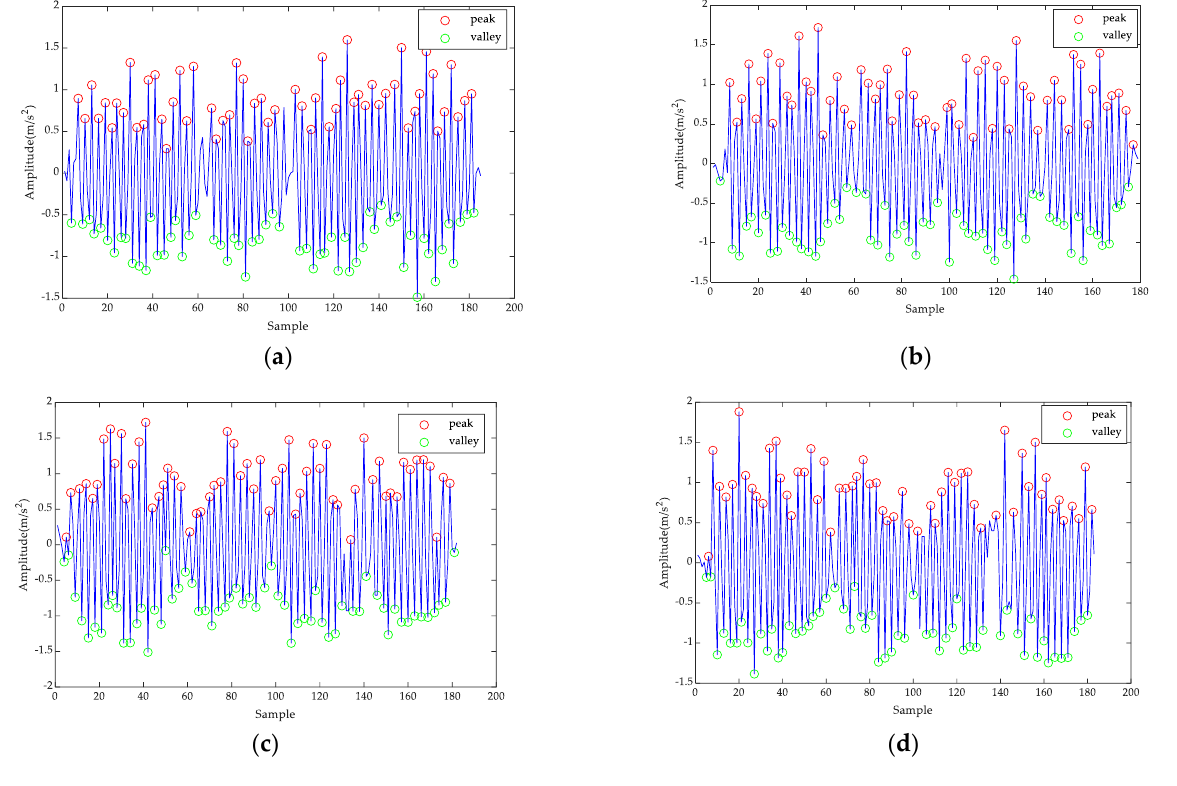
Figure 8. The peak and valley detection results with Honor60, VivoY85a, and two different height pedestrians in the second scene. ( a ) Volunteer #1 with a VivoY85a cell phone. ( b ) Volunteer #2 with a VivoY85a cell phone. ( c ) Volunteer #1 with an Honor60 cell phone. ( d ) Volunteer #2 with an Honor60 cell phone.